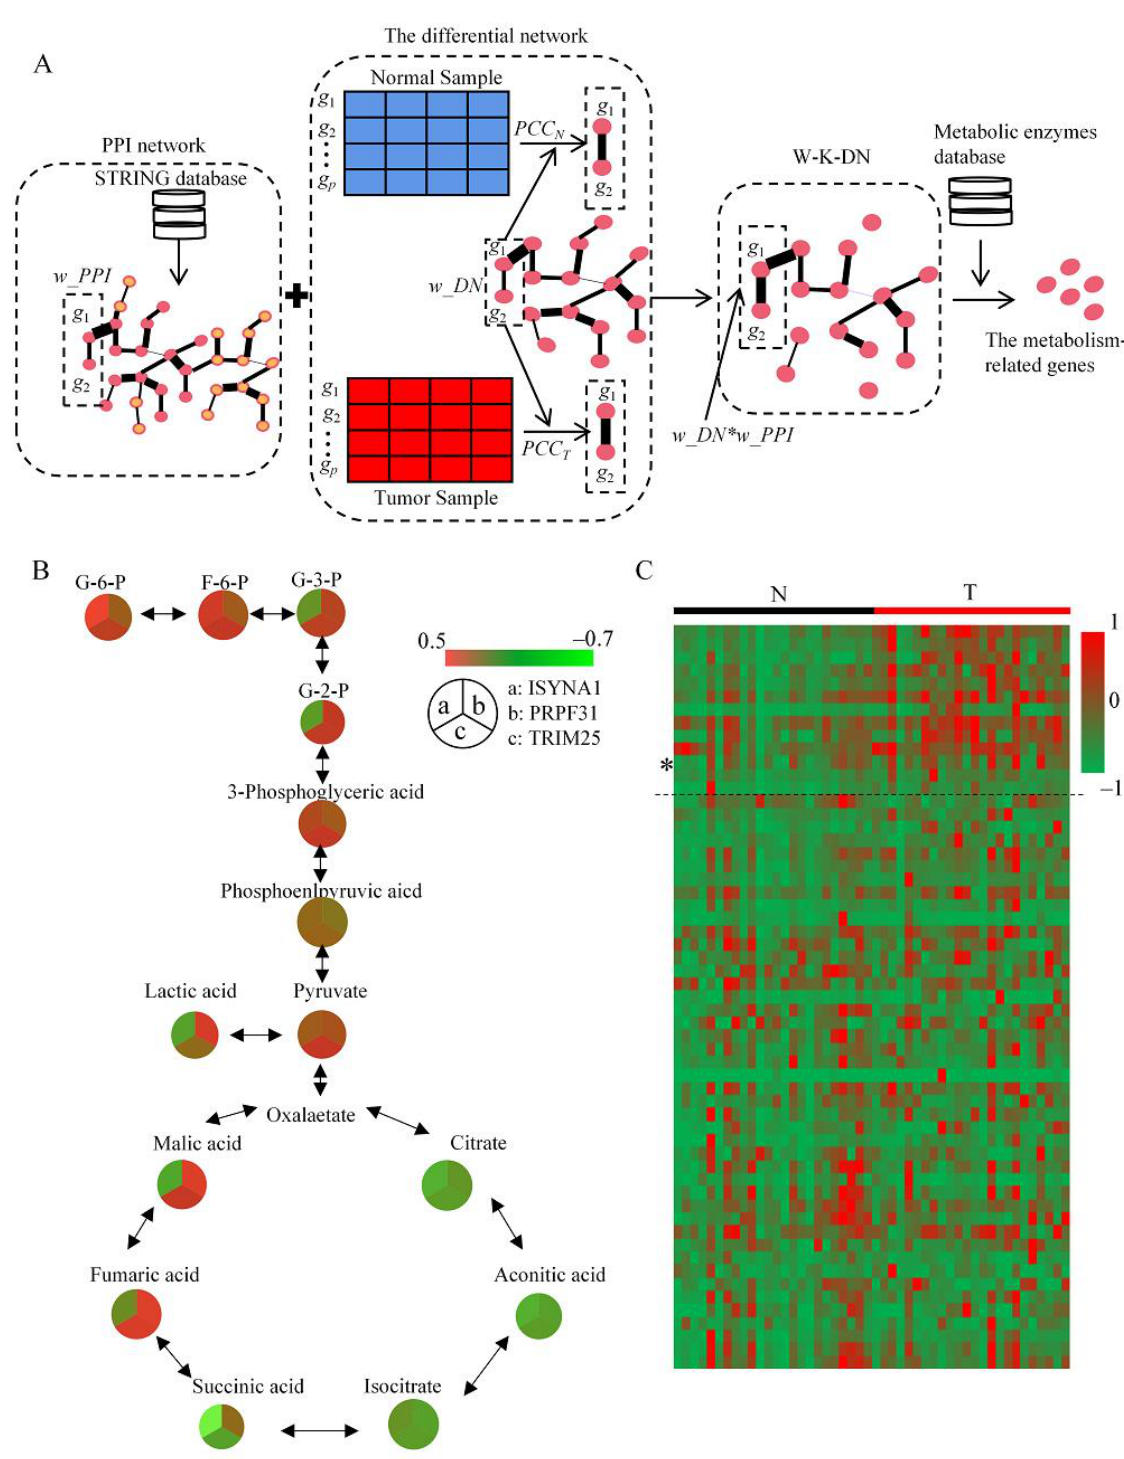
Figure 1. Screening of the genes that promote prostate cancer development. ( A ) Flowchart of the method (DMRG) of defining the important metabolism-related genes. ( B ) Analysis of the correlation between three key genes (ISYNA1, PRPF31, TRIM25) and glucose metabolism. ( C ) Heat map analysis of TRIM family gene expression levels in 24 paired PCa/normal tissues from the transcriptomic dataset. “N” represents normal tissue. “T” represents PCa tumor tissue. * p < 0.05.